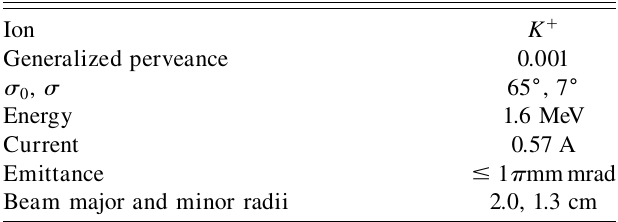
TABLE I. Parameters required at the entrance to the example transport